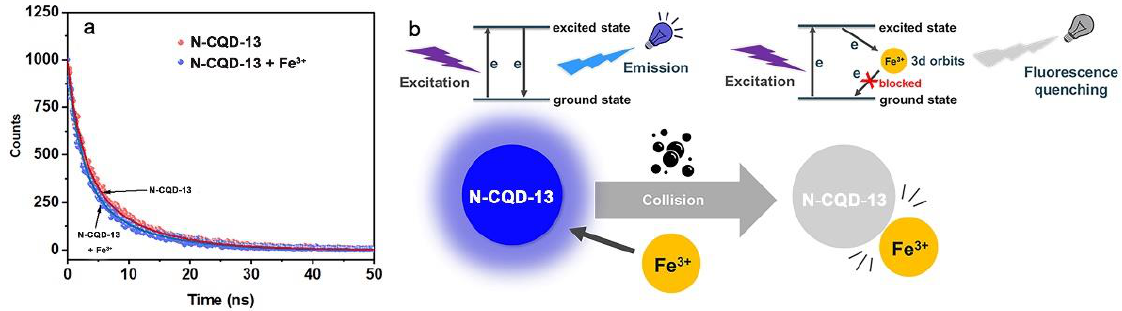
Figure 10. ( a ) Fluorescence lifetime of N-CQD-13 (80 mg/L) solutions untreated (red) and treated (blue) with Fe 3+ (500 μM). ( b ) The probable interaction model between N-CQD-13 and Fe 3+ .